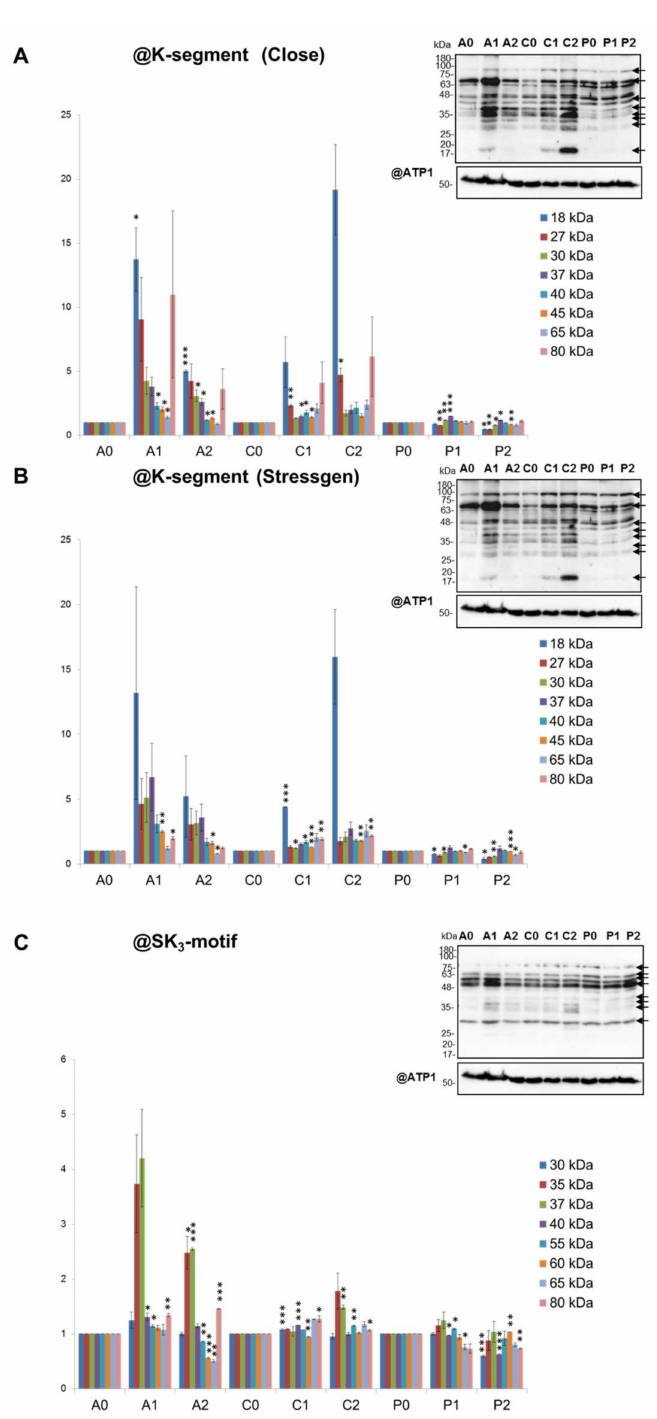
Figure 5. (pp. 11 and 12) Dlps abundance in mitochondria from control grown “ Adelanto ”, “ Casper ” and “ Pionier ” plants (A0, C0, P1), plants grown in moderate (A1, C1, P1) and severe water deficiency (A2, C2, P2, respectively). Results of analysis of dlps of various size (in kDa) on representative SDS-polyacrylamide gel blots with antibodies directed against ( A ) dehydrin K-segment from Close [51] (@K-segment (Close)) or from ( B ) Stressgen (@K-segment (Stressgen)), or ( C ) antibodies recognizing dehydrin SK 3 motif (@SK 3 ) are shown. For loading control, antibody against mitochondrial ATP synthase subunit α (@ATP1) is used. For molecular mass calibration, PageRuler Prestained Protein Ladder (Thermo Scientific, Gda´nsk, Poland) is applied. The protein molecular mass is indicated in kDa. Investigated dlps are marked by arrows on gel blots. Significant alterations from triplicate detection in ( A ), ( B ) and ( C ) are marked with asterisks: ***, p < 0.001, **, p < 0.01, *, p < 0.05 versus control values for each cultivar. Further data in the